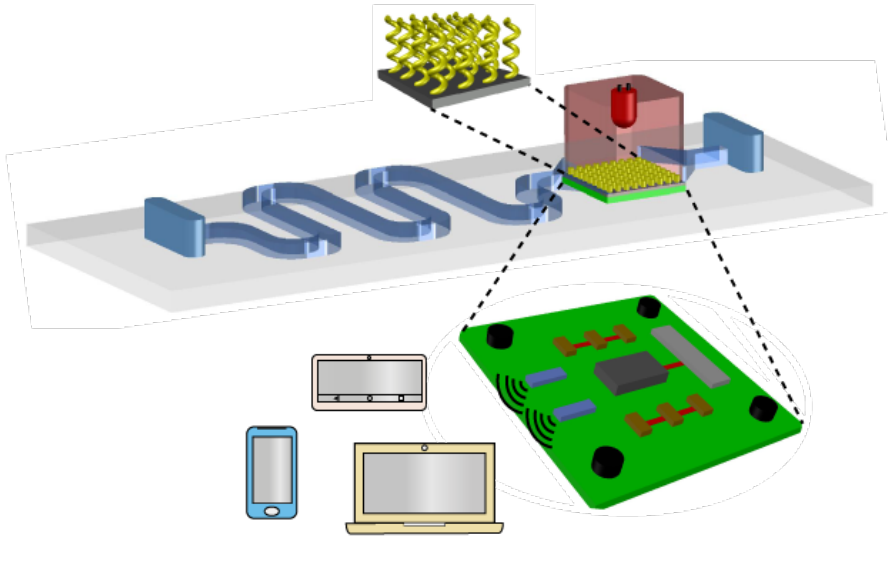
Figure 13. Chiral plasmonics for PoC devices integrated with IoT: Biosensing device working as a PoC device that collects samples, e.g., blood, treats them in the microfluidic system (blue way) to reach the plasmonic chamber. The chiral plasmonic structure with suitable functionalization will capture the enantiomer of interest. The optical response following the light incidence will be transduced into electrical pulses by the transductor (grey component in the circuit board), amplified in a three-stage amplification (brown components) and emitted to near or remote device as a radiofrequency (RF) signal (the antennas are the blue